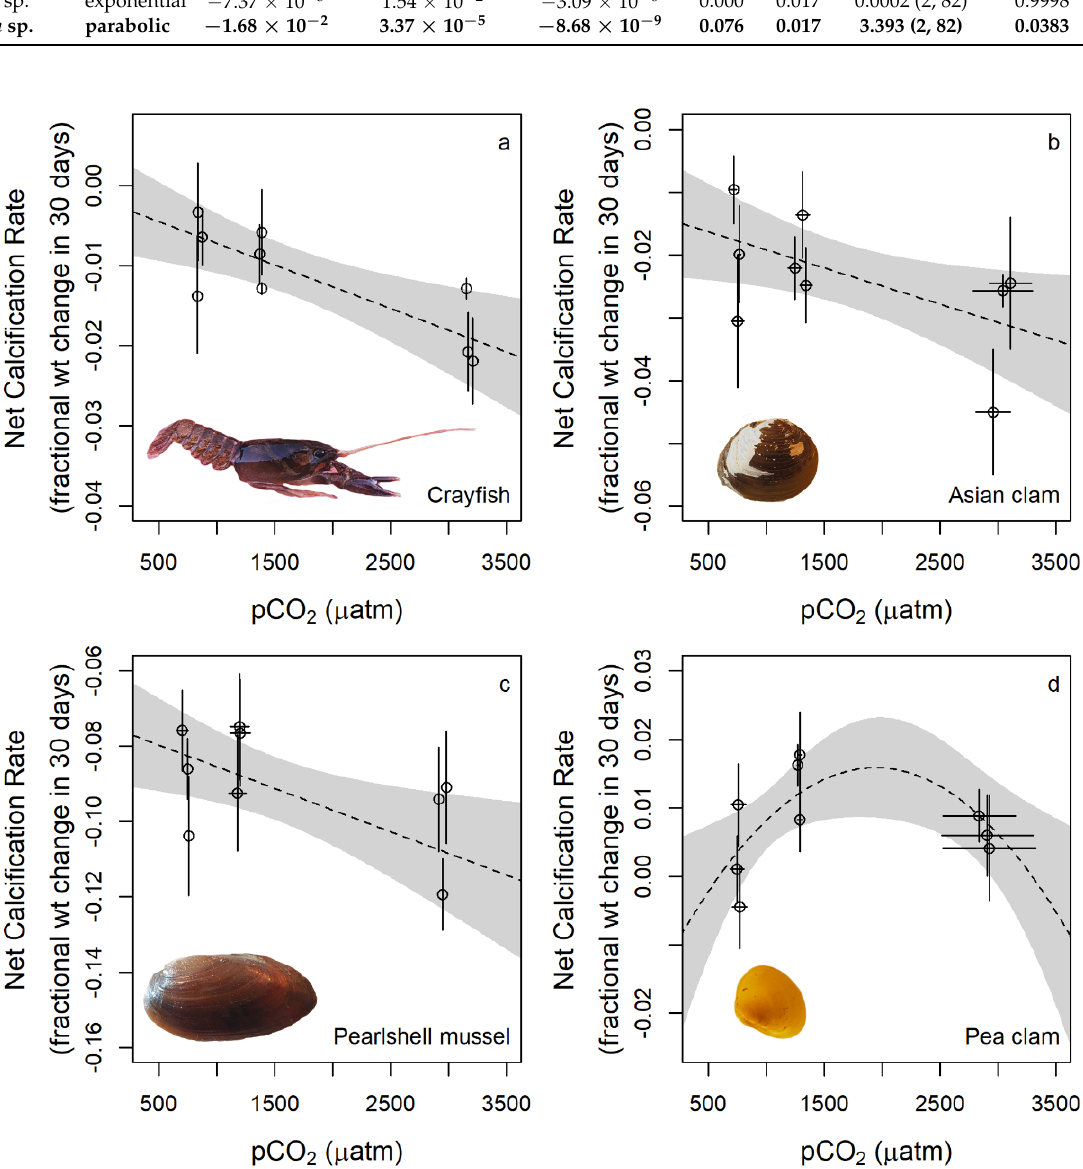
Figure 4. Net calcification rates (expressed as fractional change in buoyant or wet weight normal- ized to 30-day growth interval) as a function of water pH for ( a ) the signal crayfish, Pacifastacus leniusculus (n = 33, 2 − 6 individuals per tank); ( b ) the Asian clam, Corbicula fluminea (n = 95, 6 − 15 individuals per tank); ( c ) the Eastern pearlshell mussel, Margaritifera margaritifera (n = 62, 2 − 10 indi- viduals per tank); and ( d ) the pea clam, Pisidium sp. (n = 85, 6 − 15 individuals per tank). All species shown exhibit a linear negative response in net calcification rate to increasing pCO 2 , except for the pea clam that exhibits a parabolic response. Data markers represent the average net calcification rates for all individuals in each of the three replicate tanks for each of the three pCO 2 treatments. Vertical bars represent the standard error of the net calcification rates, while the horizontal bars represent the standard deviation of pCO 2 during the incubations. Shaded regions represent the 95% confidence intervals of the best fitting model.